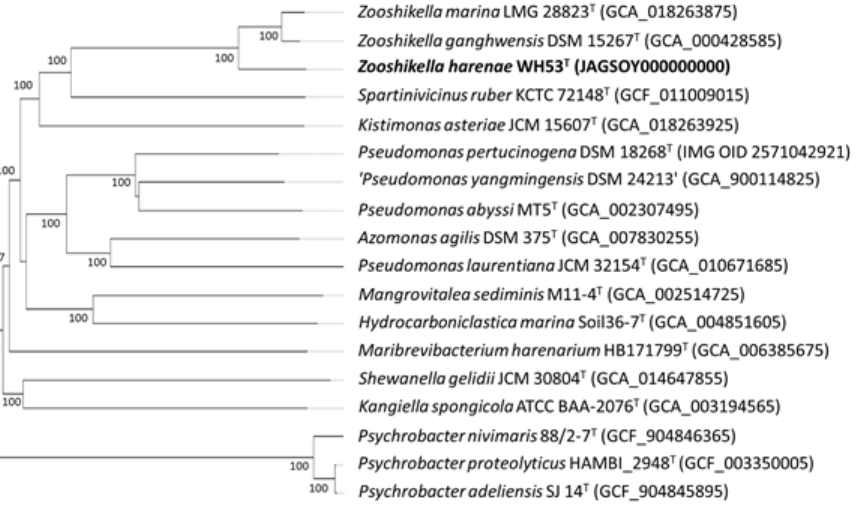
Figure 3. Phylogenomic tree inferred from whole-proteome-based GBDP distances showing rela- tionships between strain WH53 T and the closely related type strains based on Type (Strain) Genome Server (TYGS) (https://tygs.dsmz.de/) (accessed on 03 November 2021) [54]. The number at the nodes are GBDP pseudo-bootstrap support values >60% from 100 replications, with average branch support of 94.1%.